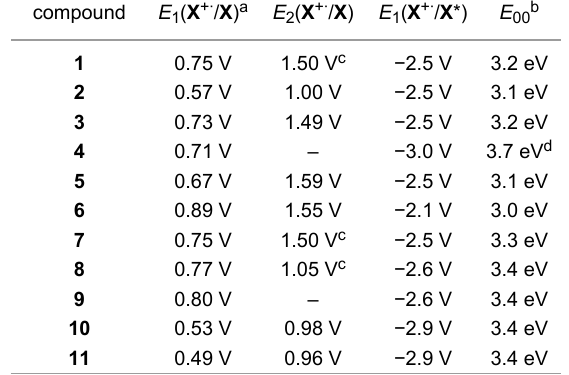
Table 1: Reduction potentials E red ( X + · / X ) of N -phenylphenothiazines 1 – 11 (determined by cyclic voltammetry using ferrocene as standard).